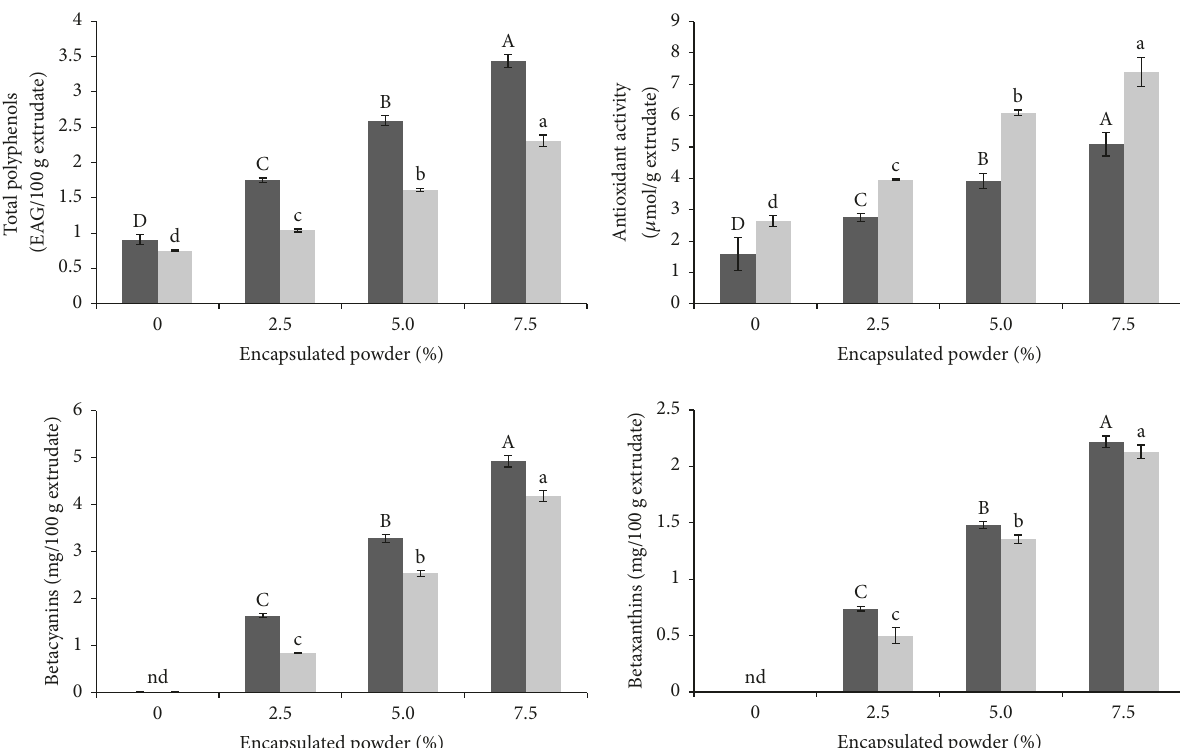
Figure 3: Total polyphenols, antioxidant activity, betacyanins, and betaxanthins: dark grey columns: mixture before extrusion-cooking process and grey columns: extruded cereal; using encapsulated powder of red cactus pear to pigment; different letter indicates significant difference (𝑃 < 0.05) .